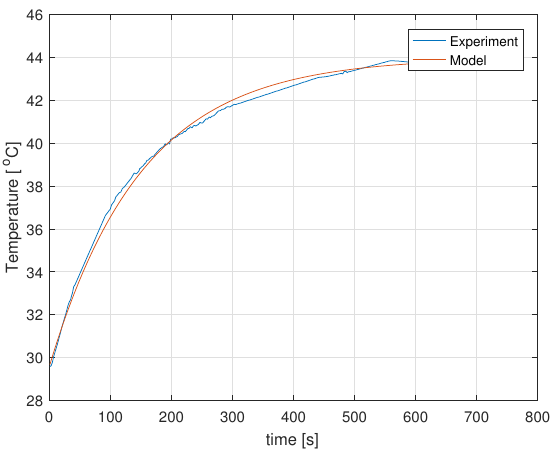
Figure 10. The step responses of the IO model and real plant for area 2.